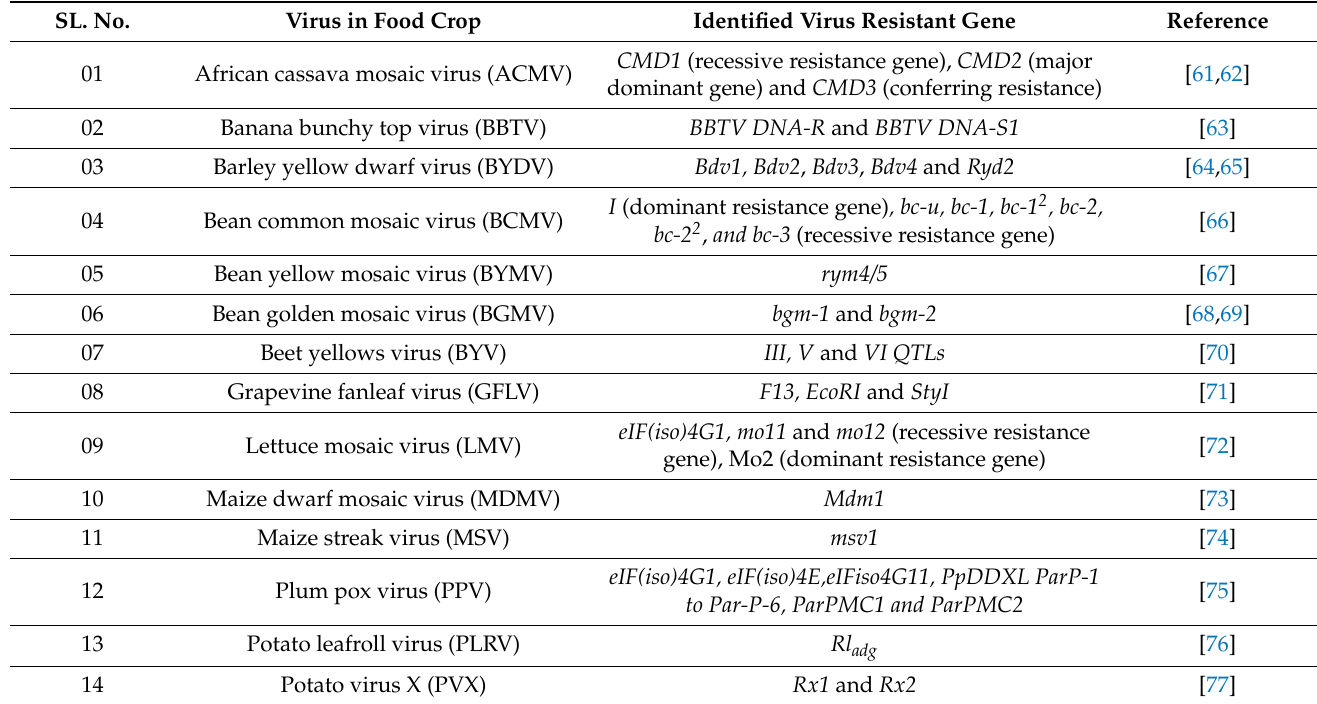
Table 3. A list of identified virus resistance genes in 20 food crops, is expected to apply CRISPR/Cas9 to control viral diseases. SL.